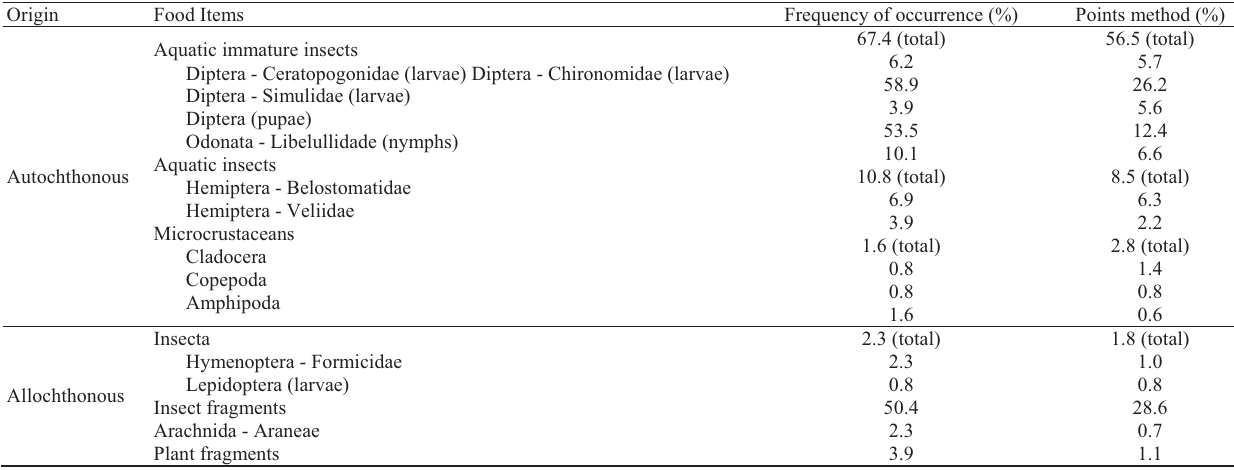
Table 1. Food items found in 129 stomach contents of Rivulus luelingi from a Coastal Atlantic Rainforest stream in southern Origin